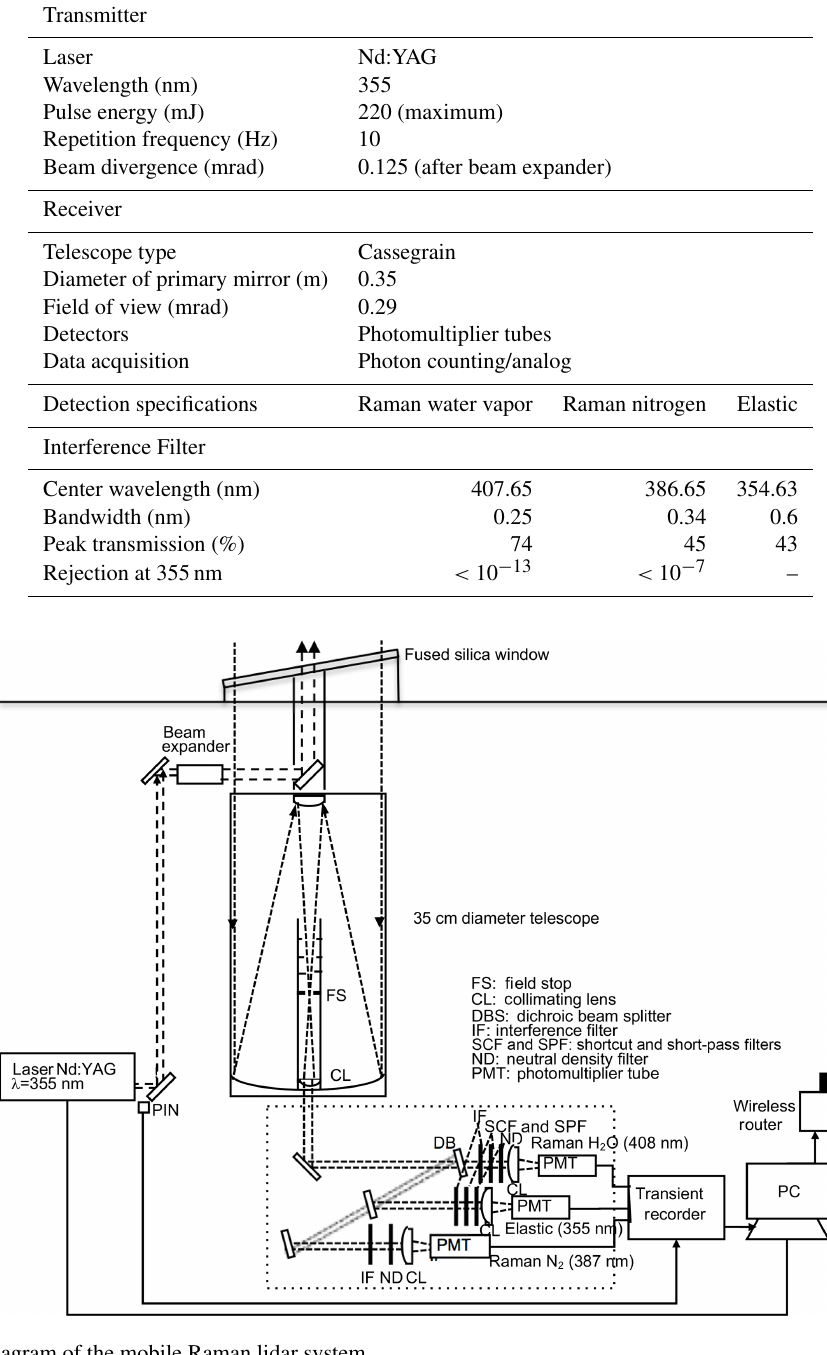
Figure 1. Schematic diagram of the mobile Raman lidar system.